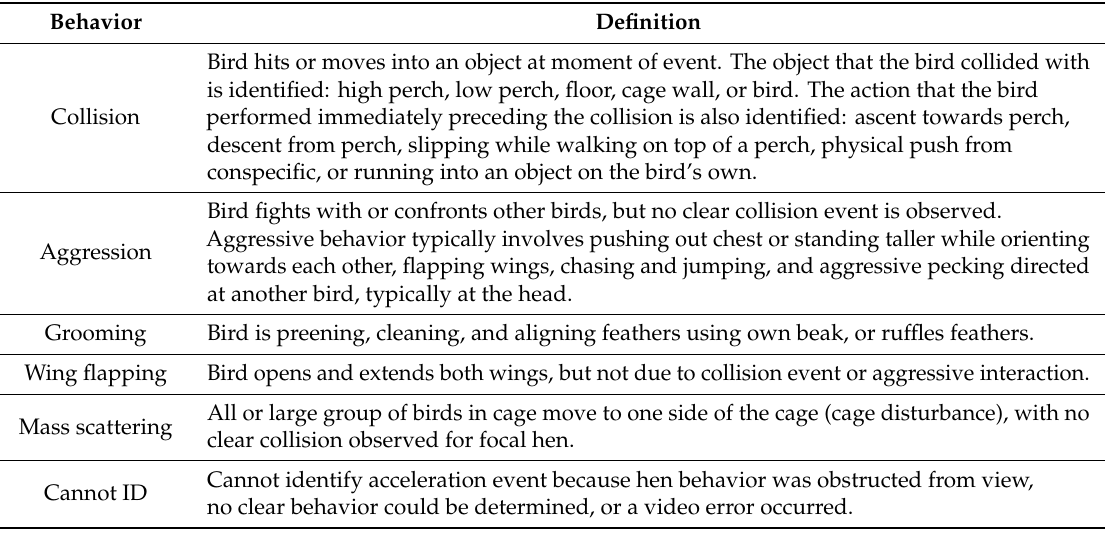
Table 1. Definitions of behaviors associated with acceleration